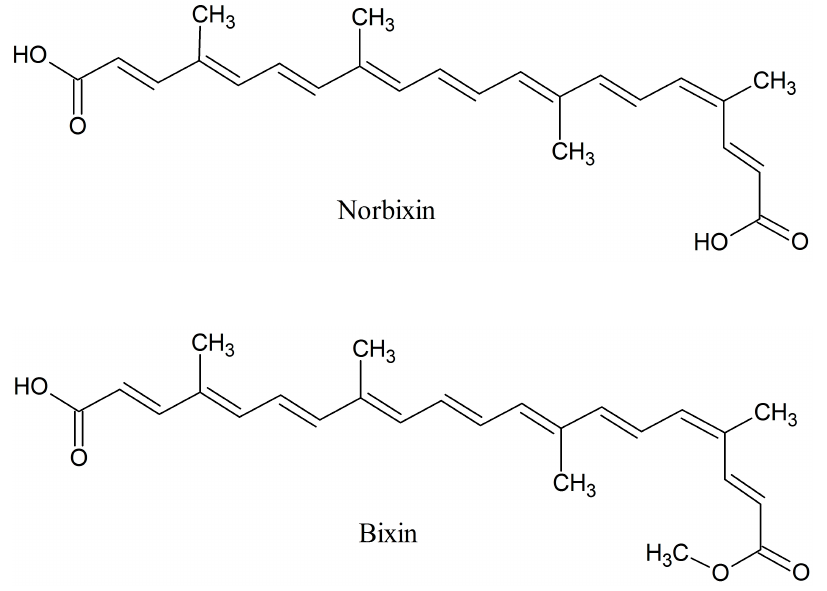
Figure 1. Chemical Structures of bixin and